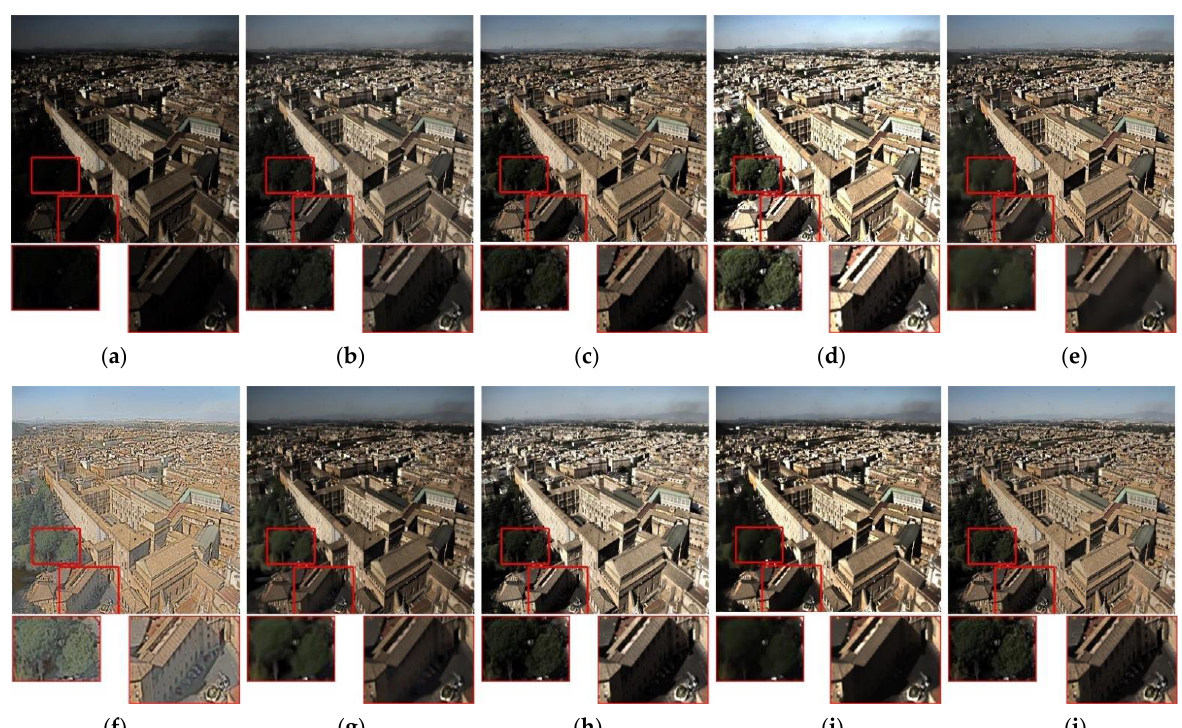
Figure 13. Enhanced results of “Plant and Shadow” image. ( a ) Original image; ( b ) BIMEF; ( c ) MF; ( d ) LIME; ( e ) SR; ( f ) Ret-Net; ( g ) FFM; ( h ) LECARM; ( i ) SDD; ( j )